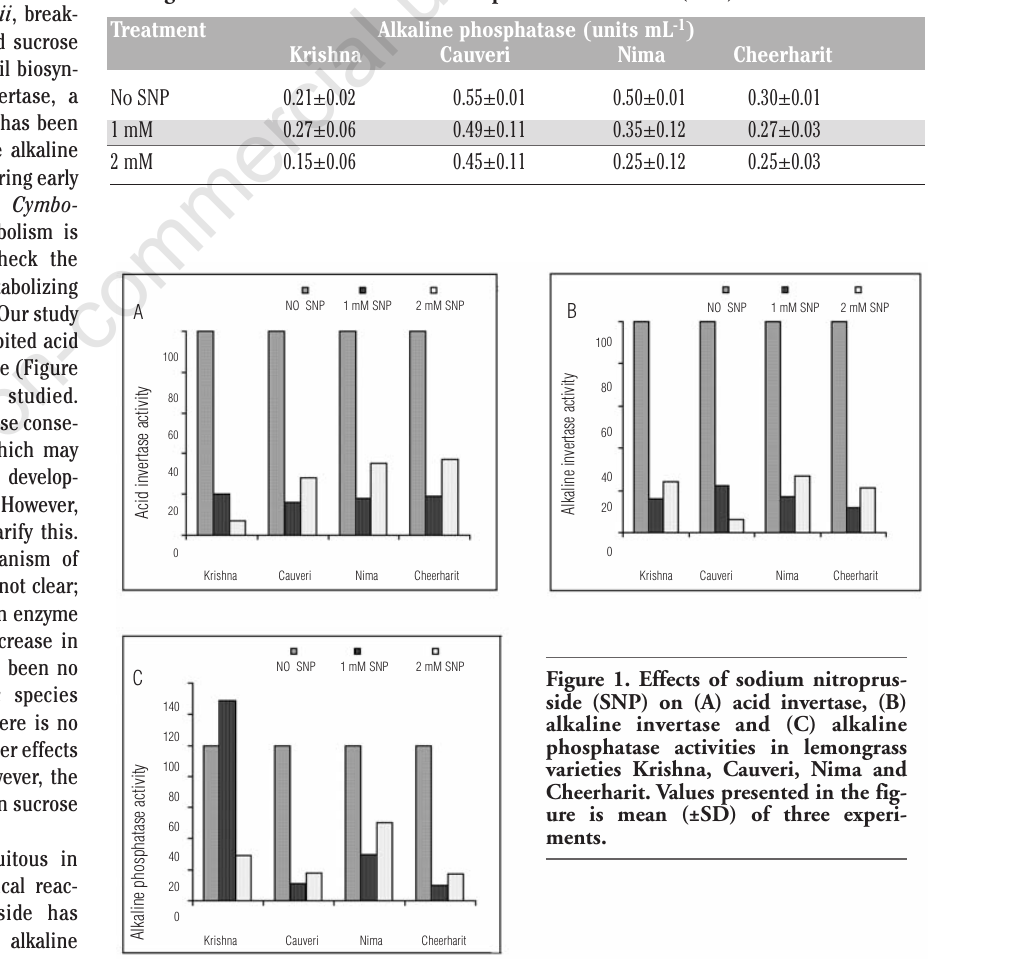
Table 4. Effect of sodium nitroprusside(SNP) on alkaline phosphatase activity in Cymbopogon flexuosus varieties Krishna, Cauveri, Nima and Cheerharit. A 15 d lemon- readings were recorded and values were expressed as the mean (±SD).